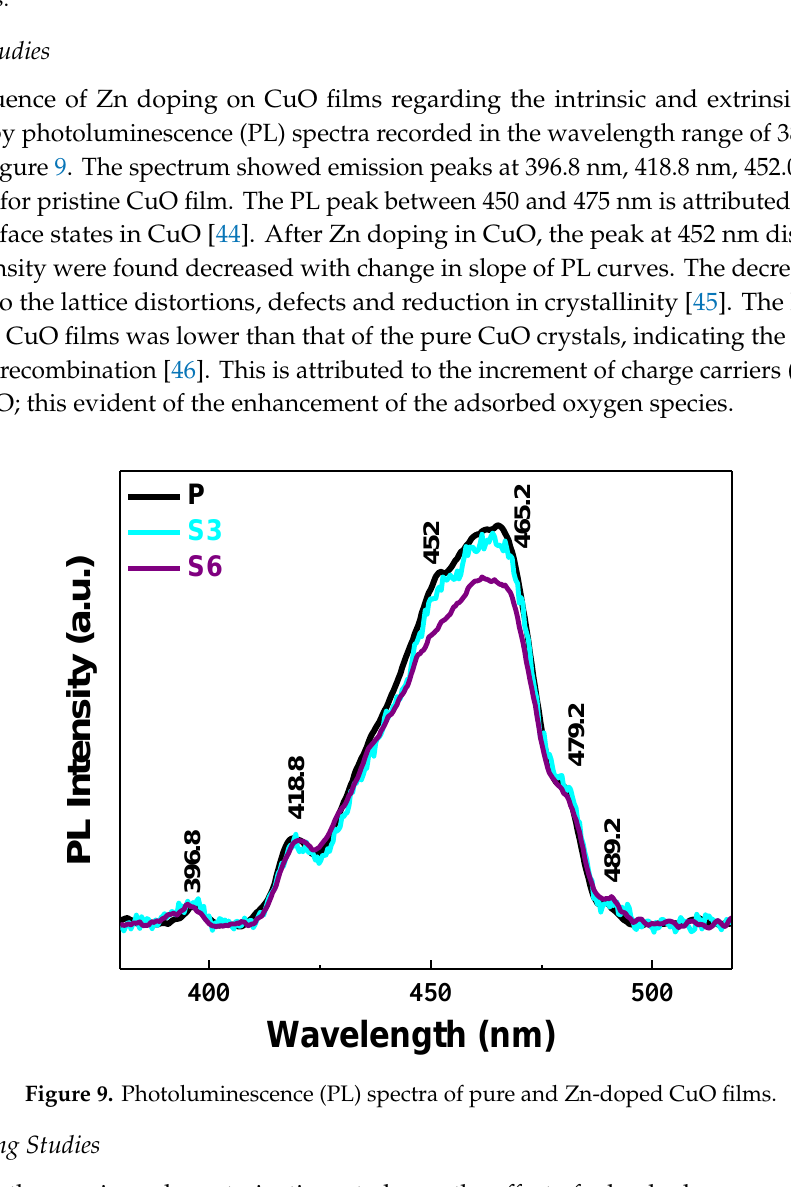
Figure 8. X-ray photoelectron spectra of ( a ) Cu 2p, ( b ) O 1s, and ( c ) Zn 2p for pure and Zn-doped CuO films.